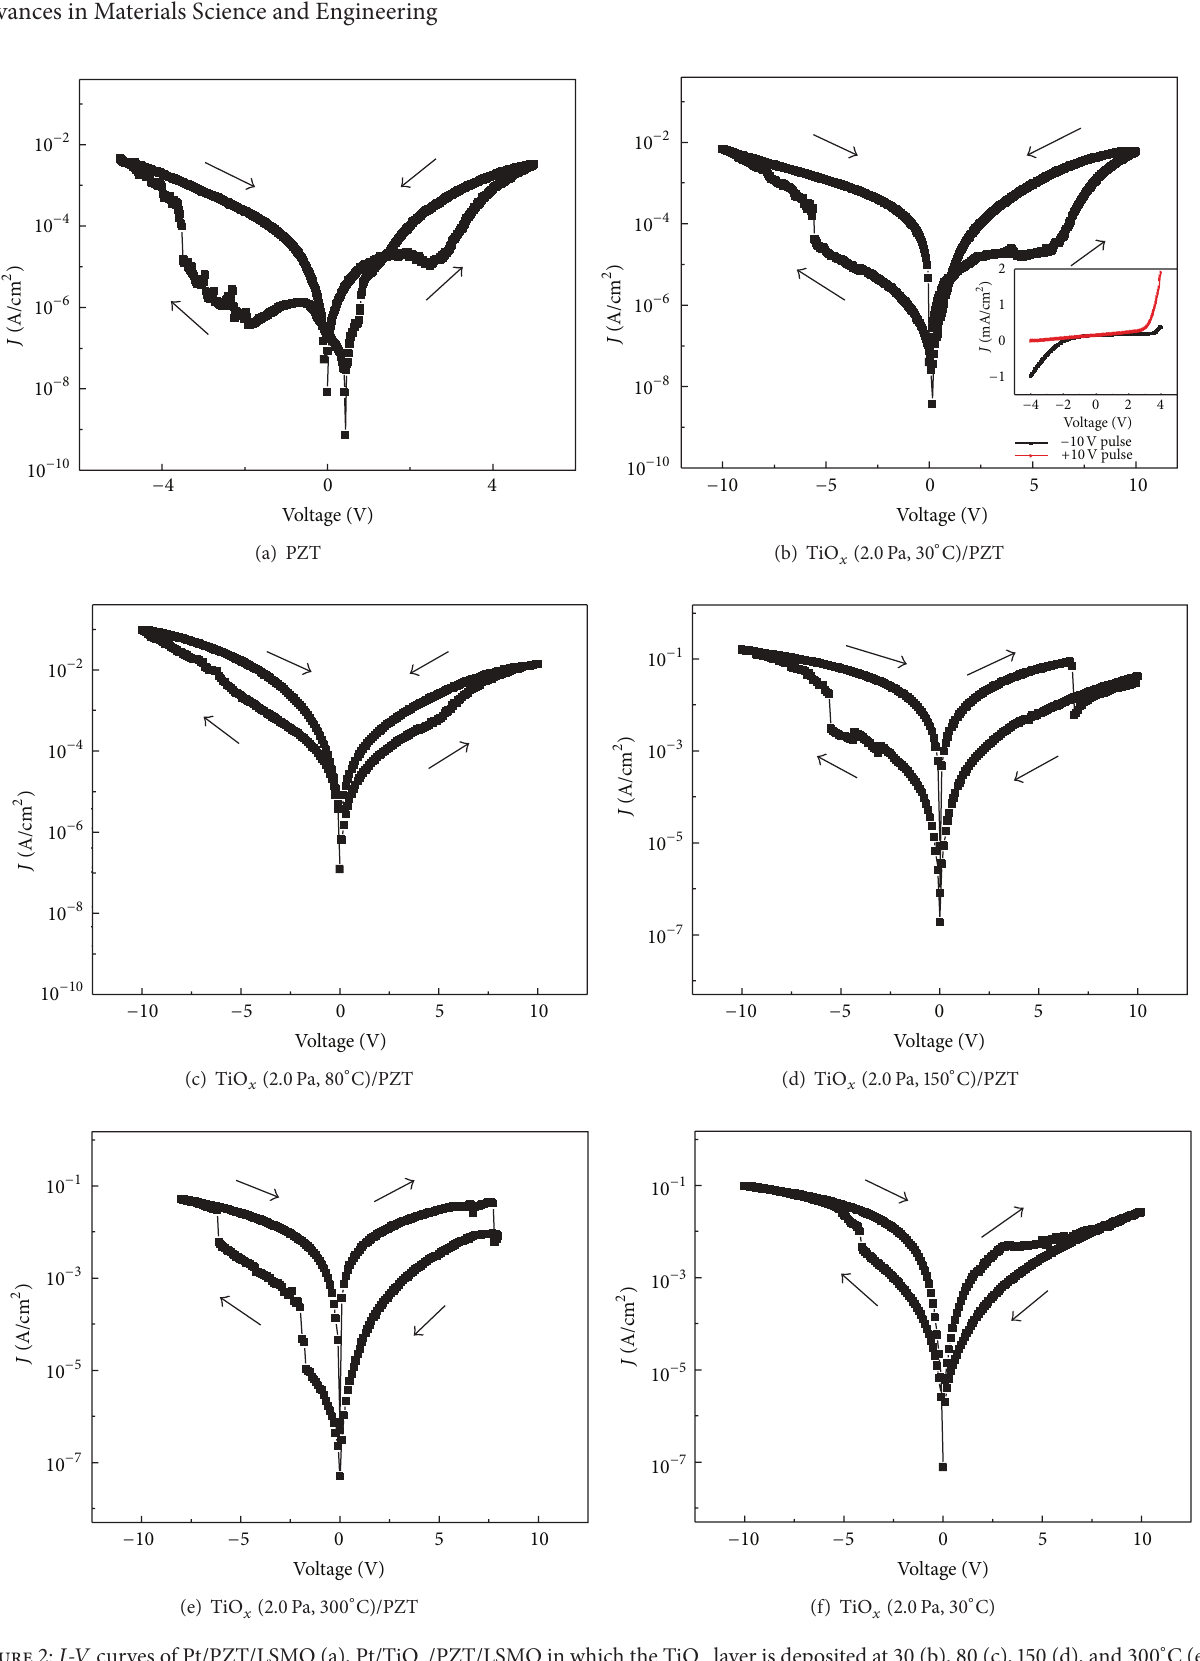
Figure 2: 𝐼 - 𝑉 curves of Pt/PZT/LSMO (a), Pt/TiO 𝑥 /PZT/LSMO in which the TiO 𝑥 layer is deposited at 30 (b), 80 (c), 150 (d), and 300 ∘ C (e) in 2.0 Pa oxygen pressure and Pt/TiO 𝑥 /LSMO in which the TiO 𝑥 layer is deposited at 30 ∘ C in 2.0 Pa oxygen pressure (f). The arrows indicate the voltage sweeping directions. The inset in (b) shows the 𝐼 - 𝑉 curves measured after the PZT layer is poled to opposite